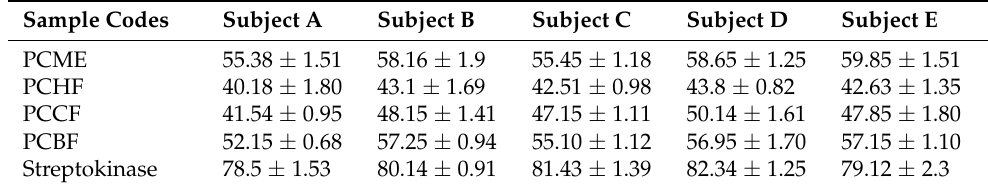
Table 6. Thrombolytic activity (% clot lysis) of fractions of P. candollei from different blood samples (subject